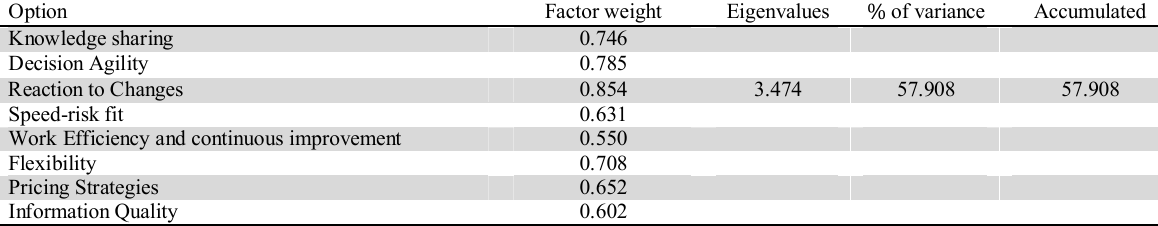
The summary of factors associated with dynamic organization